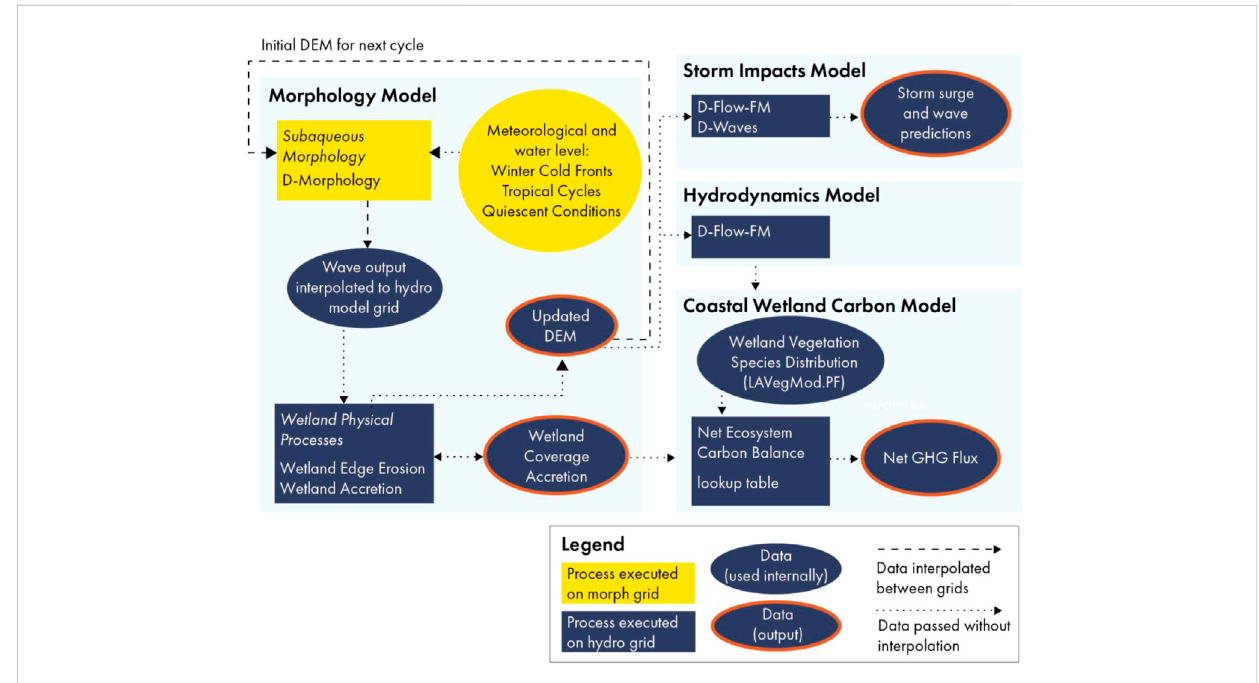
FIGURE 1 Schematic of the coastal systems modeling